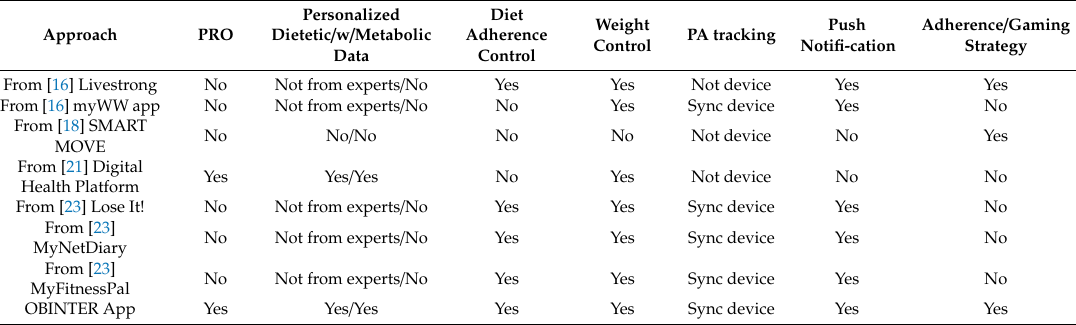
Table 1. Comparative of the di ff erent approaches from the state-of-the-art in relation with the OBINTER